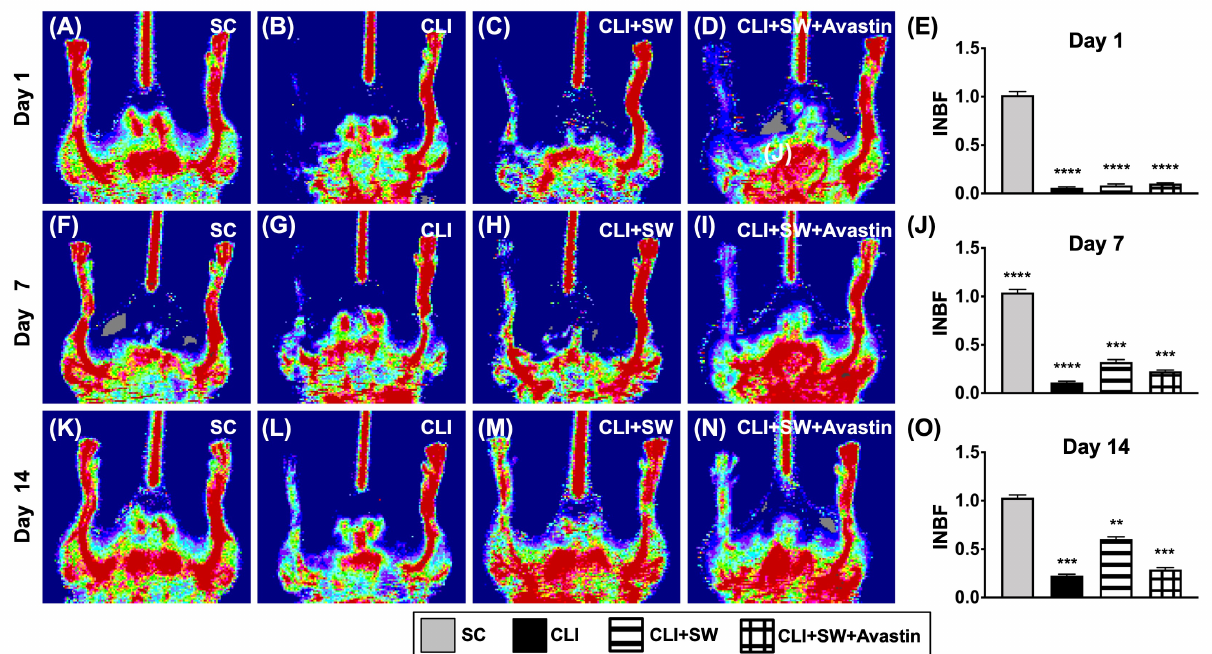
Figure 4. Ischemic/normal blood flow (INBF) ratio measured by laser Doppler scan at days 1, 7 and 14 after left CLI induction. ( A – D ) Illustrating the laser Doppler finding of ratio of left limb (ischemia) to right limb (normal) blood flow (i.e., INBF) at day 1 after CLI procedure among the four groups. ( E ) Analytical result of ratio of INBF, **** for p < 0.0001. ( F – I ) Illustrating the laser Doppler finding of ratio of INBF at day 7 after CLI procedure among the four groups. ( J ) Analytical result of ratio of INBF, *** for p < 0.001, **** for p < 0.0001. ( K – N ) Illustrating the laser Doppler finding of ratio of INBF at day 14 after CLI procedure among the four groups. ( O ) Analytical result of ratio of INBF, ** for p < 0.01, *** for p < 0.001, n = 6 for each group. SC = sham-operated control; SW = shock